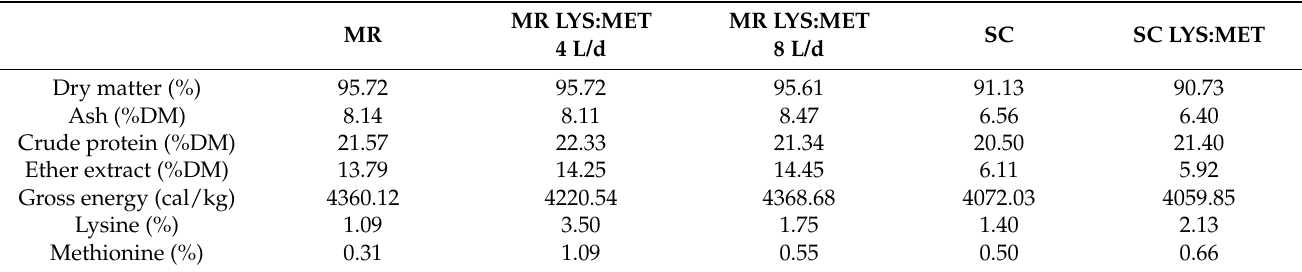
Table 1. Chemical composition of milk replacer (with 4 and 8 L/d supply) and starter with or without lysine and methionine